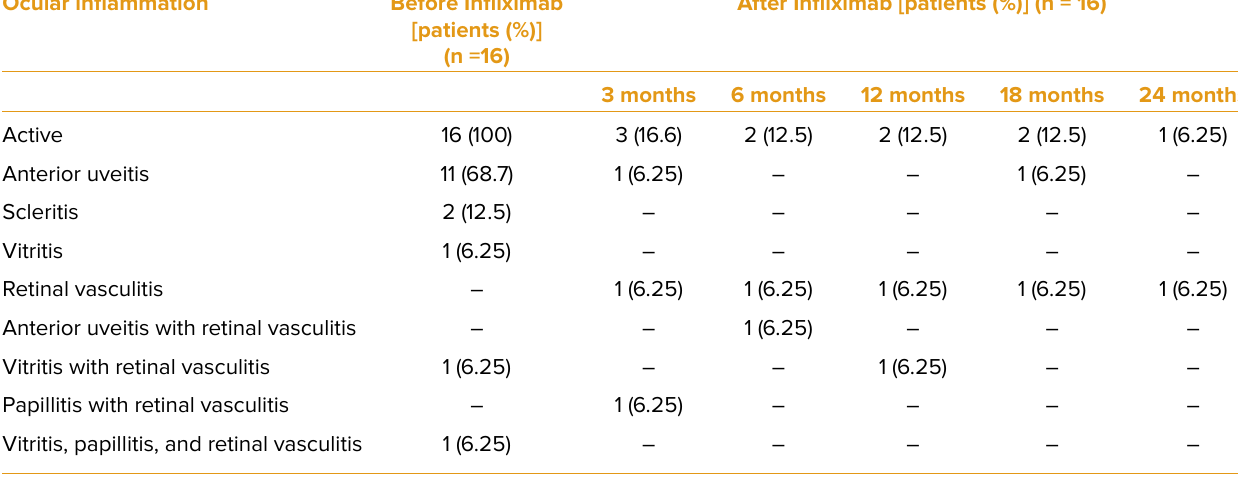
Table 2. Inflammation status before and after the infliximab therapy excluding inactive patients Ocular inflammation Before Infliximab